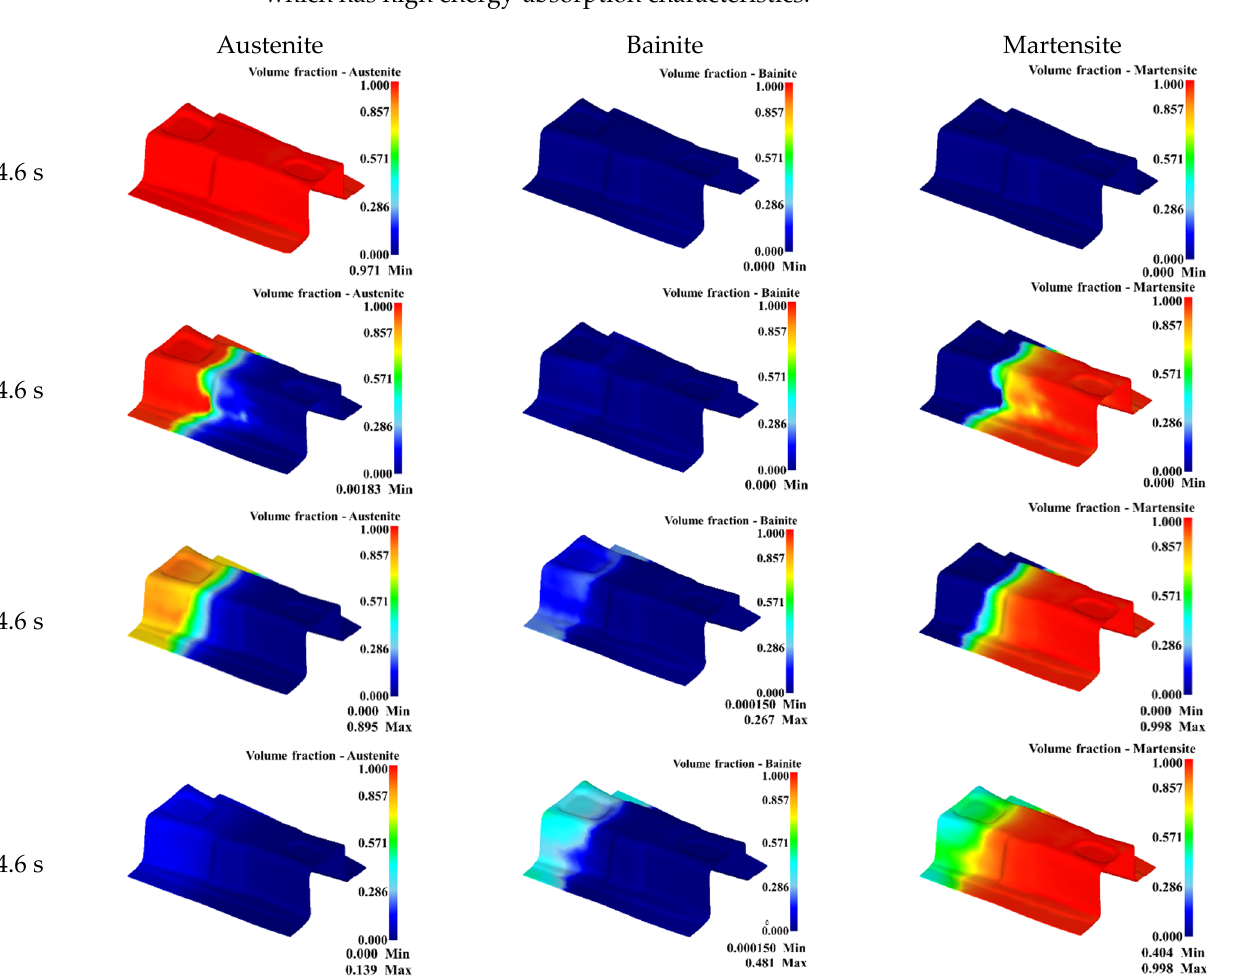
Figure 21. Volume fraction of austenite, bainite, and martensite for gradient zone of B-pillar. In addition, during the hot-stamping process, the contact time between the B-pillar and die at different positions was different, resulting in different phase transformation processes and final microstructures. Therefore, the final microstructure distribution of three typical parts, namely the flange edge, side wall, and top of the B-pillar, were studied. In order to study the volume fractions of the distribution of bainite and martensite in detail, 18 tracking points were uniformly selected from the flange edge, side wall, and top of the B-pillar, and then the volume fraction curve of bainite and martensite over tracking point was drawn, as shown in Figure 22. As can be seen from Figure 22, in the side wall of B-pillar, the volume fraction of martensite was small at P1 to P4, and it increased rapidly from P4 to P7, and then it reached stability. On the contrary, the variation of the